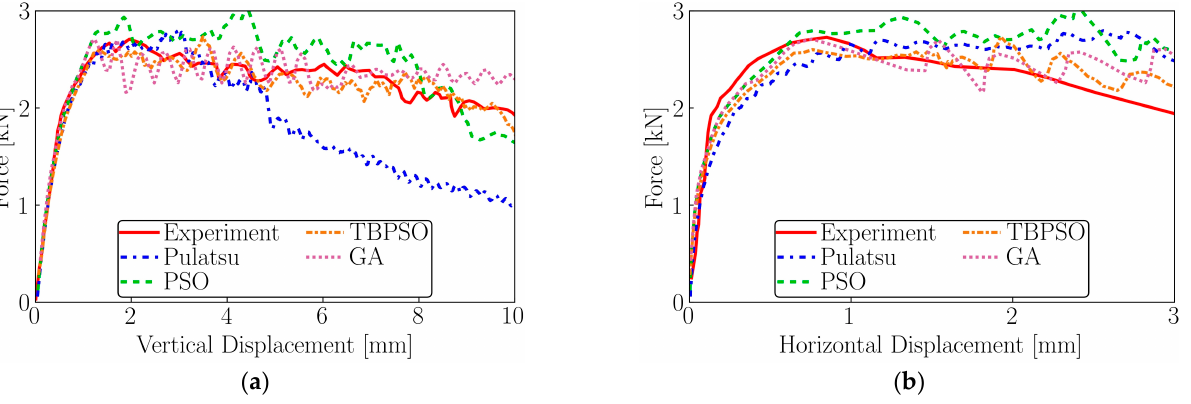
Figure 21. Calibrated material parameter load displacement diagrams of densely meshed geometry (objective function 1, PSO and GA: 50 iterations; TBPSO: 20 iterations): ( a ) vertical displacement, ( b ) horizontal displacement.